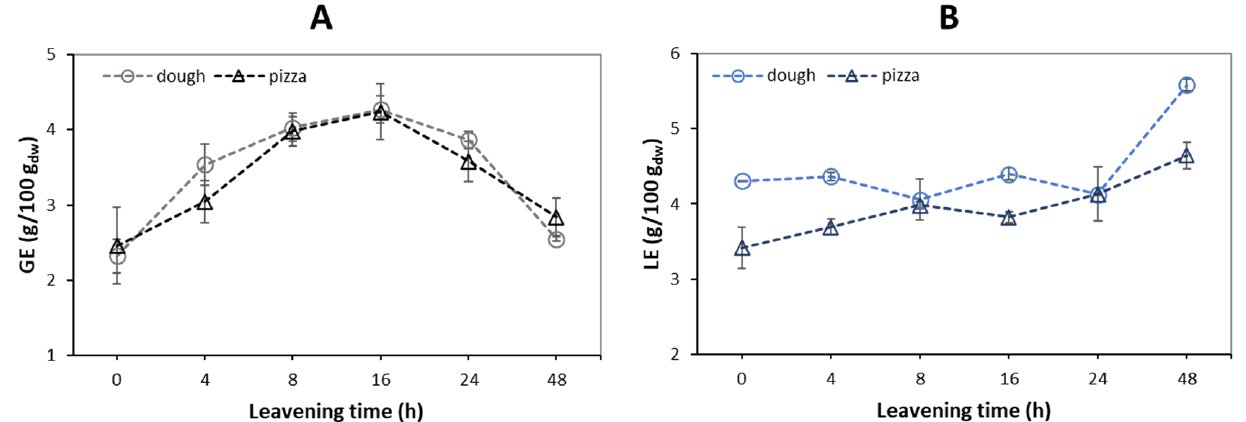
Figure 4. Reducing sugars ( A ) and free amino groups ( B ) of the dough and wood oven-baked pizza base at a selected leavening time. Values are mean ± SD ( n = 4). GE, glucose equivalent reducing sugars; LE, leucin equivalent free amino groups.